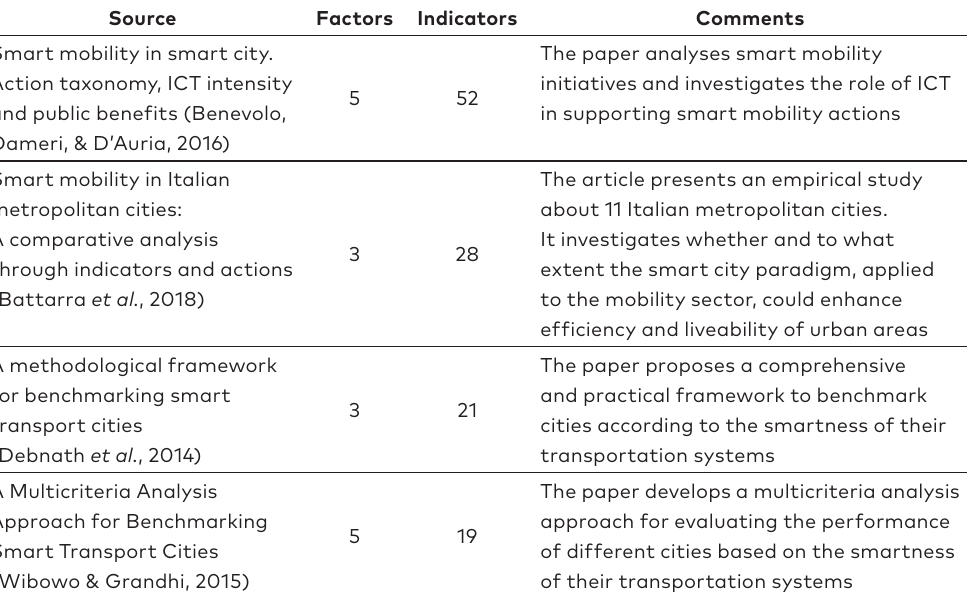
Table 2. Sample reviewed articles presenting different factors and indicators Source Factors